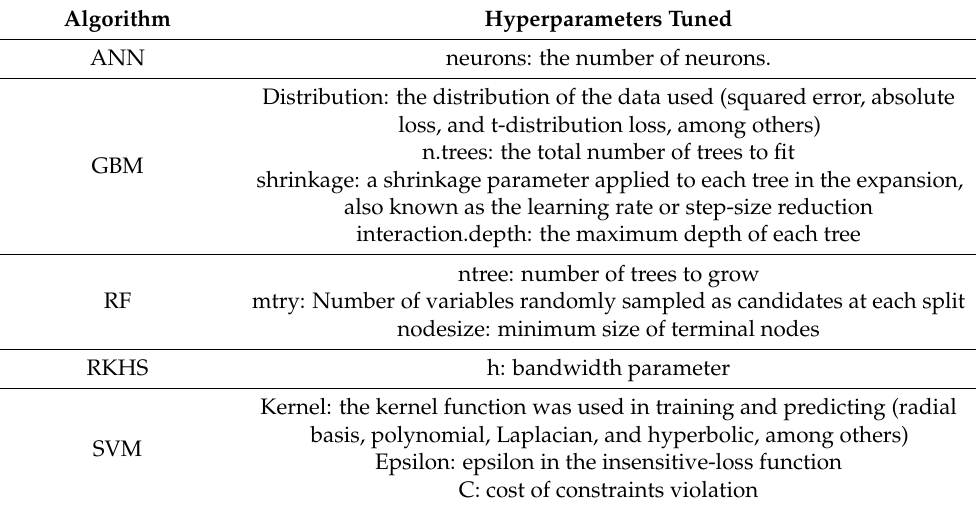
Table 2. Hyperparameters tuned in each